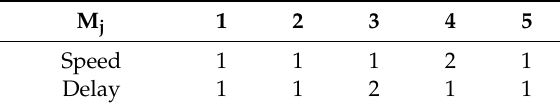
Table 4. Speed ( SD j ) and delay ( C j ) of the shared resources.